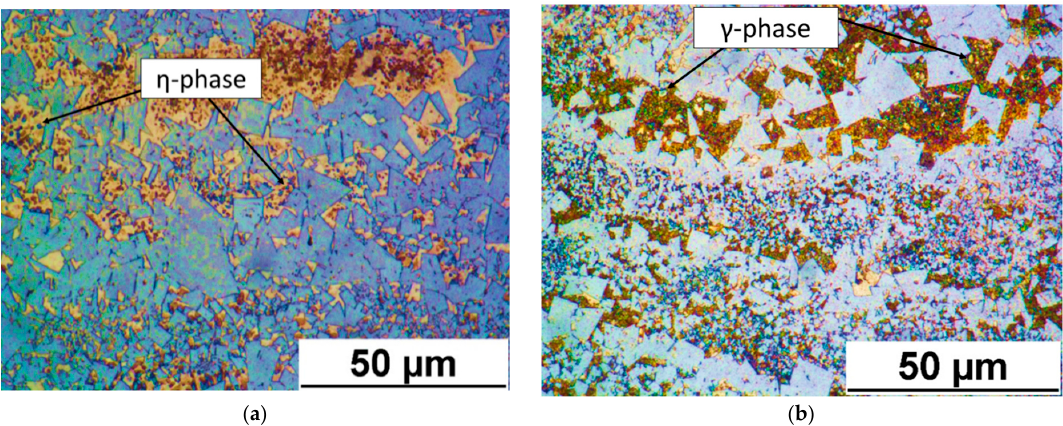
Figure 6. Micrographs revealing ( a ) η -phase (round shaped and blue coloured) and ( b ) γ -phase (yellow to brown coloured with round shape).